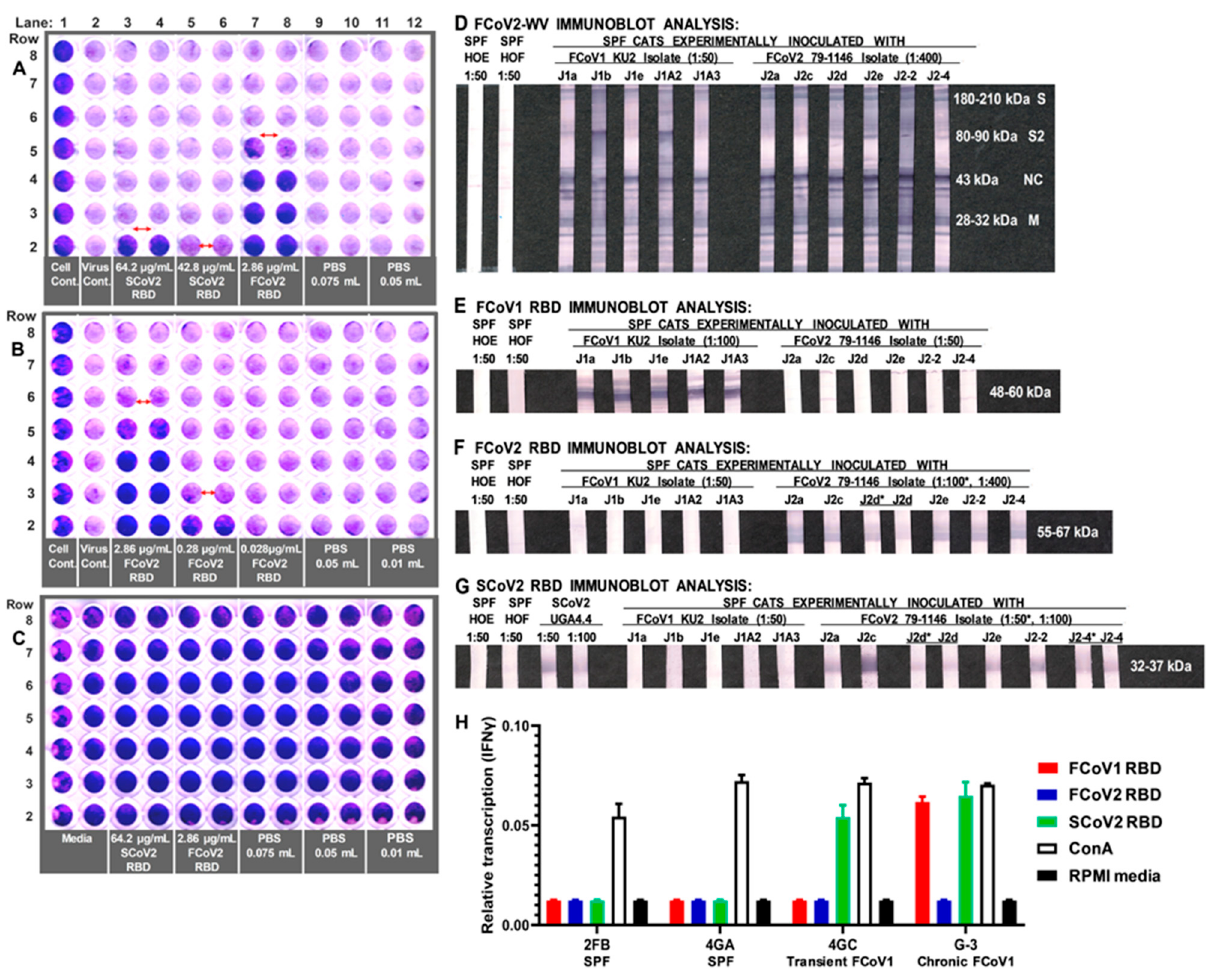
Figure 4. The in vitro FCoV2 infection-blocking activity of the proposed FCoV2 RBD and the SCoV2 RBD followed by the immunoblot analyses of the sera from FCoV-inoculated cats. In Plate A ( A ), the lanes consisted of media control without virus (rows 2–8, lane 1), virus control (rows 2–8, lane 2), SCoV2 RBD starting at 64.2 ug/mL (row 2, lanes 3–4), SCoV2 RBD starting at 42.8 ug/mL (row 2, lanes 5–6), FCoV2 RBD starting at 2.86 ug/mL (row 2, lanes 7–8), 0.075 mL of PBS in the first well (row 2, lanes 9–10), and 0.05 mL PBS in the first well (row 2, lanes 11–12). Each well in lanes 3–12, starting from row 3, are serial three-fold dilutions of the RBD or PBS. The RBD stocks were suspended in PBS. The PBS lanes represent the largest volume of the SCoV2 RBD (0.075 mL) and FCoV2 RBD (0.050 mL) used in the wells in row 2. Plate B ( B ) used the same plating scheme but had duplicate wells of FCoV2 RBD in ten-fold dilution in row 2, as described at the bottom. The 0.05 mL PBS control represents the largest volume of FCoV2 RBD used. The red horizontal double arrow shows where the blocking effect of the RBD stops when directly observed at the plate in plates A and B. The control Plate C ( C ) shows the highest amounts used for SCoV2 RBD and FCoV2 RBD for Plate A, tested without virus, to determine the potential cell toxicity caused by the RBDs. After scanning the plates at 100% brightness and 70% contrast, the plates were additionally brightened by 25% for plates A and C and 30% for Plate B, with all plates at an additional 3% contrast. Next, the plasma from five FCoV1 KU-2-inoculated laboratory cats and six FCoV2 79-1146-inoculated laboratory cats were tested for their immunoblot reactivity to FCoV2-WV ( D ), FCoV1 RBD ( E ), FCoV2 RBD ( F ), and SCoV2 RBD ( G ). The serum from two SPF cats, HOE and HOF, served as the negative controls (D-G). Additional positive control serum from SCoV2-inoculated cat UGA4.4, at 1:50 and1:100 dilutions, was included for SCoV2 RBD immunoblot ( G ). All immunoblot photographs were adjusted to 12% brightness and 5% contrast